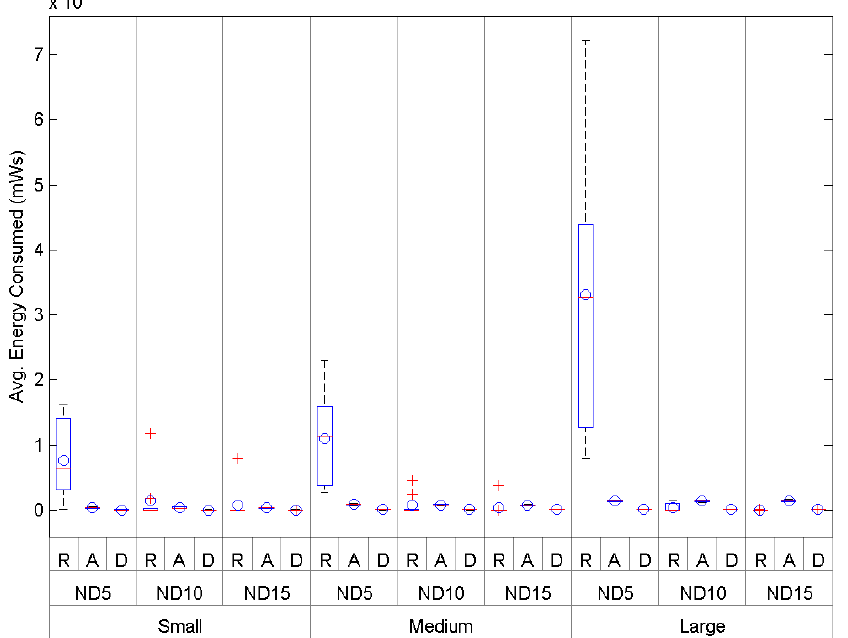
Figure 14. Comparison of the energy consumption in small-, medium- and large-size scenarios during the set-up phase. Table 5. Average energy consumption (mWs) in small-, medium- and large-size scenarios during the set-up